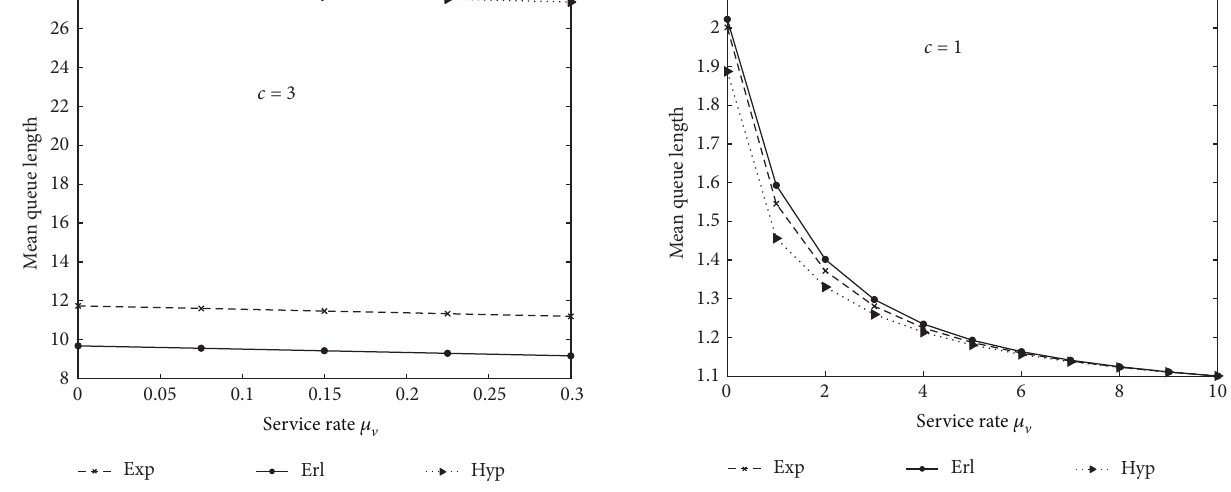
Figure 5: Mean queue length versus vacation-service rate with 𝜌 = 0.9 , 𝜉 = 1 , 𝜃 = 1 , and 𝑐 = 3 .